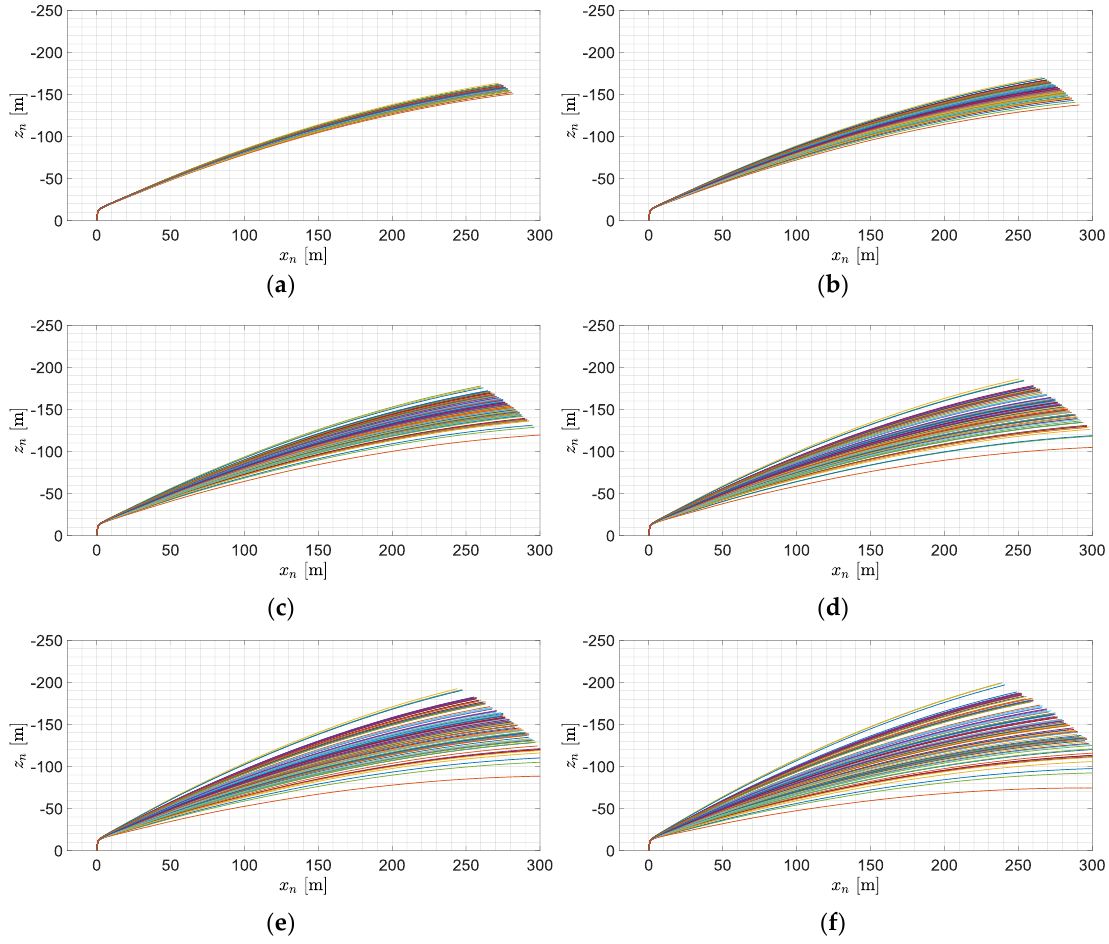
Figure 16. Projectile trajectories’ projections on 𝑂 𝑛 𝑥 𝑛 𝑧 𝑛 for various 𝜏 1 , 𝜏 2 , 𝜏 3 standard deviations: ( a ) 0.001 s; ( b ) 0.003 s; ( c ) 0.005 s; ( d ) 0.007 s; ( e ) 0.009 s; ( f ) 0.011 s.